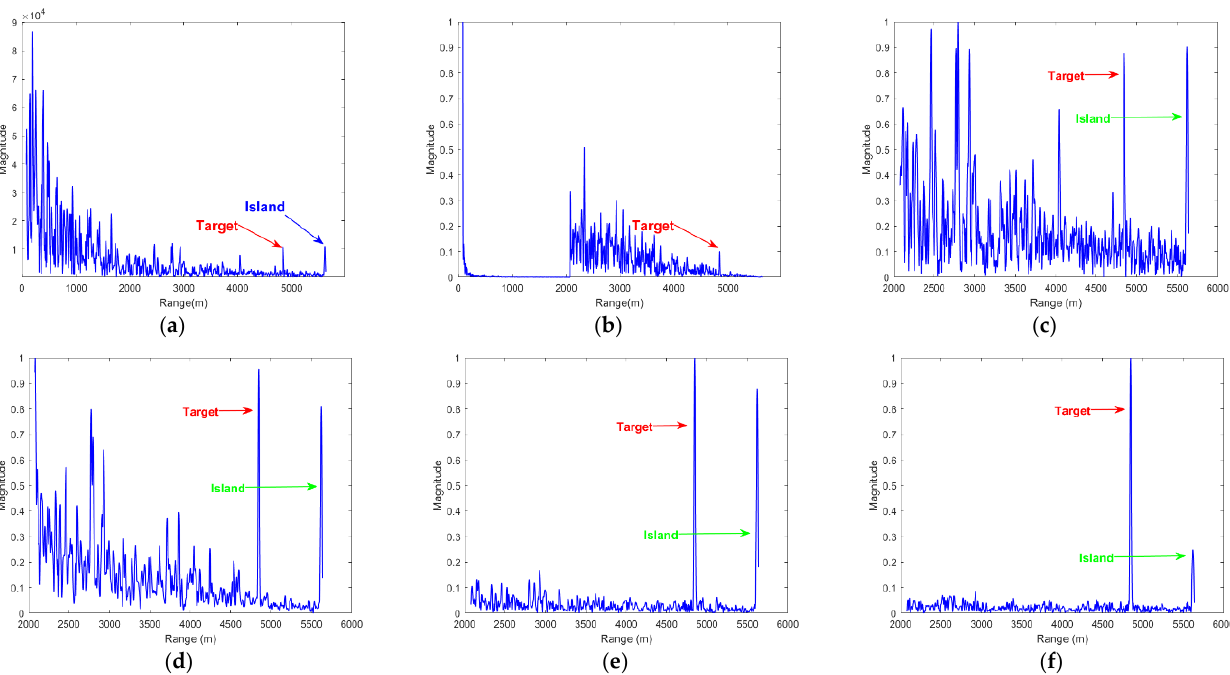
Figure 16. The clutter suppression results for PPSA. ( a ) Echo data, ( b ) the result of SVD, ( c ) the result of the target area, ( d ) the result of noncoherent accumulation, ( e ) the result of coherent accumulation, ( f ) the result of PPSA. Table 16. SCNR comparison of target 1.